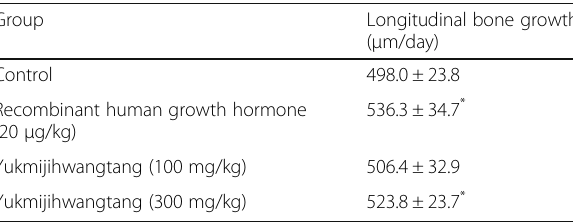
Table 2 Longitudinal bone growth rate in adolescent female rats